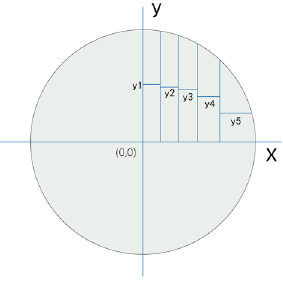
Figure 5. Find the corresponding coordinates dividing the 1/4 circle equally.